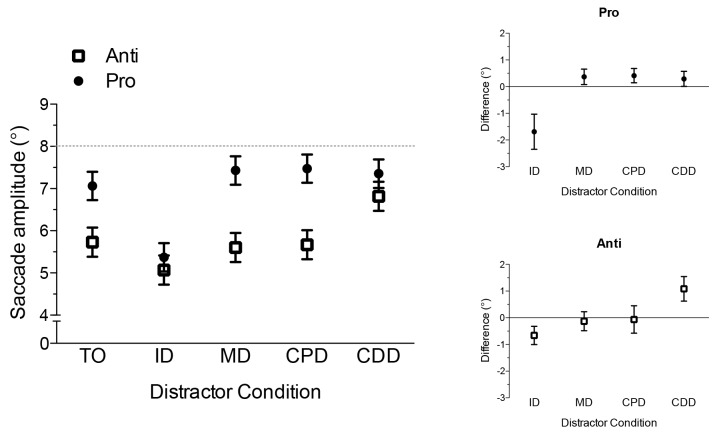
The main panel depicts mean saccade amplitude (°) in the horizontal direction for pro- (i.e., closed circles) and antisaccades (i.e., open squares) completed in target-only (TO), proximal distractor (ID), and remote distractor (MD, CPD, CDD) conditions.Error bars for this panel represent within-participant 95% confidence intervals [28]. The top-right and bottom-right offset panels show mean distractor amplitude difference scores for pro- and antisaccades, respectively. Error bars represent between-participant 95% confidence intervals [29, 30]. The absence of overlap between error bars and zero (i.e., horizontal axis) provides a graphical depiction of a reliable difference that can be interpreted inclusive to a test of the null hypothesis.